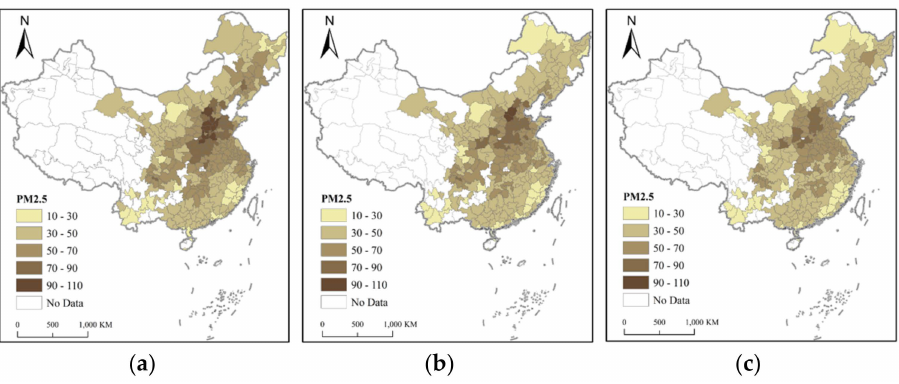
Figure 2. Spatial distribution of annual mean PM2.5 at city-level: ( a ) 2015; ( b ) 2016; ( c ) 2017.